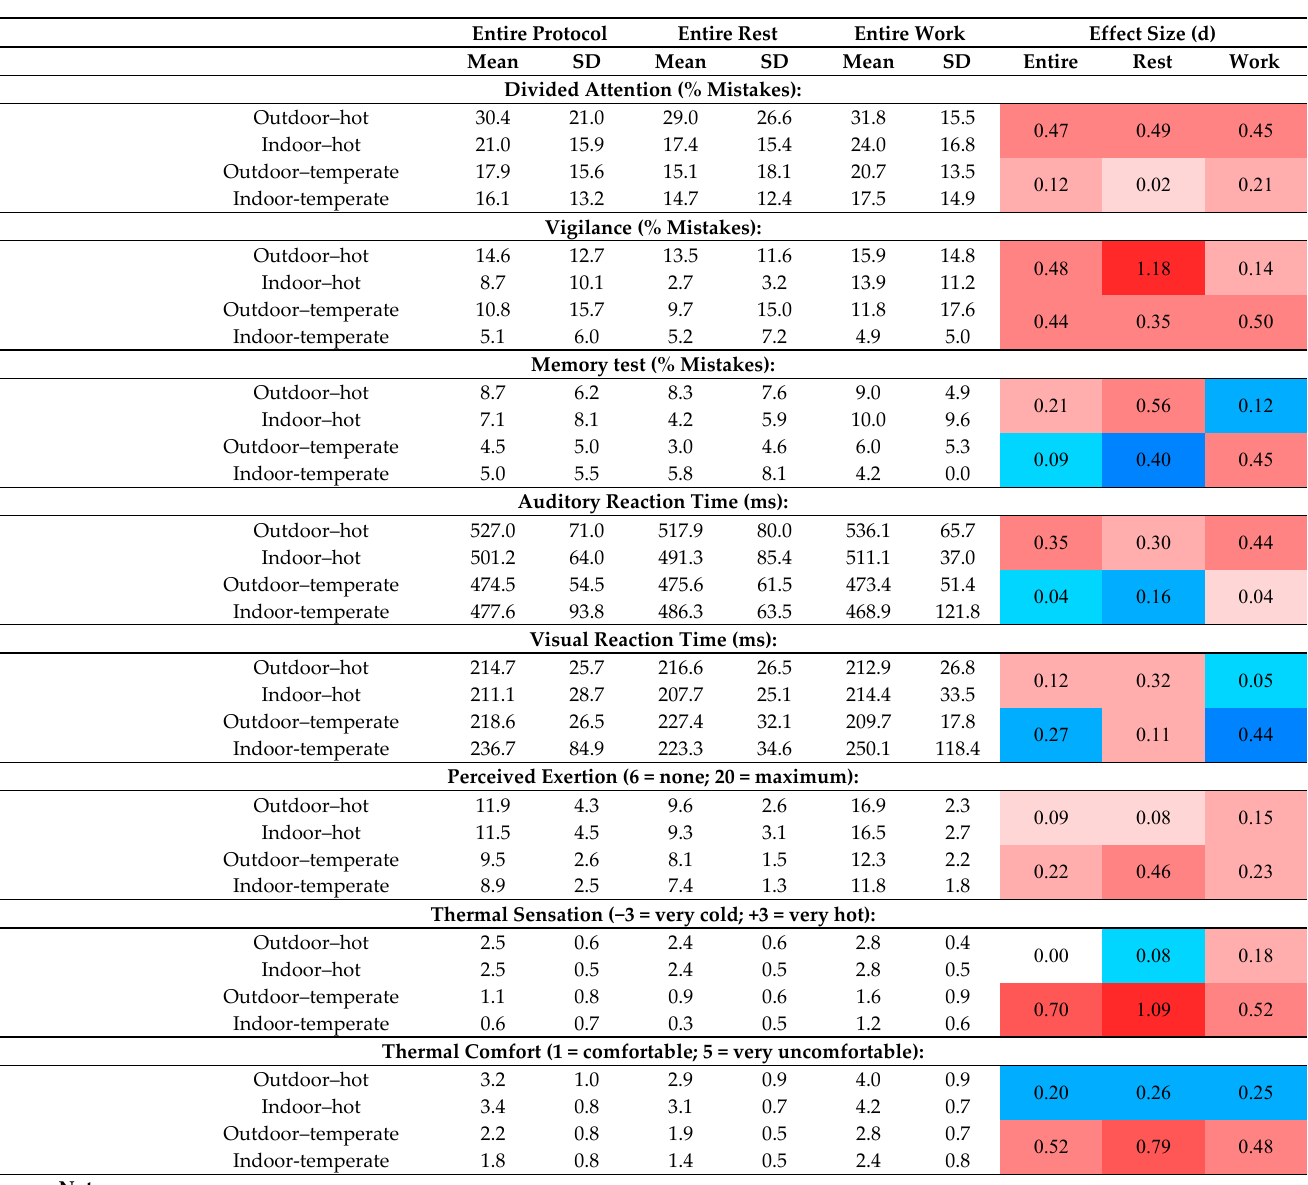
Table A5. Cont. Table A5. The effect of solar radiation on physiological responses and cognitive